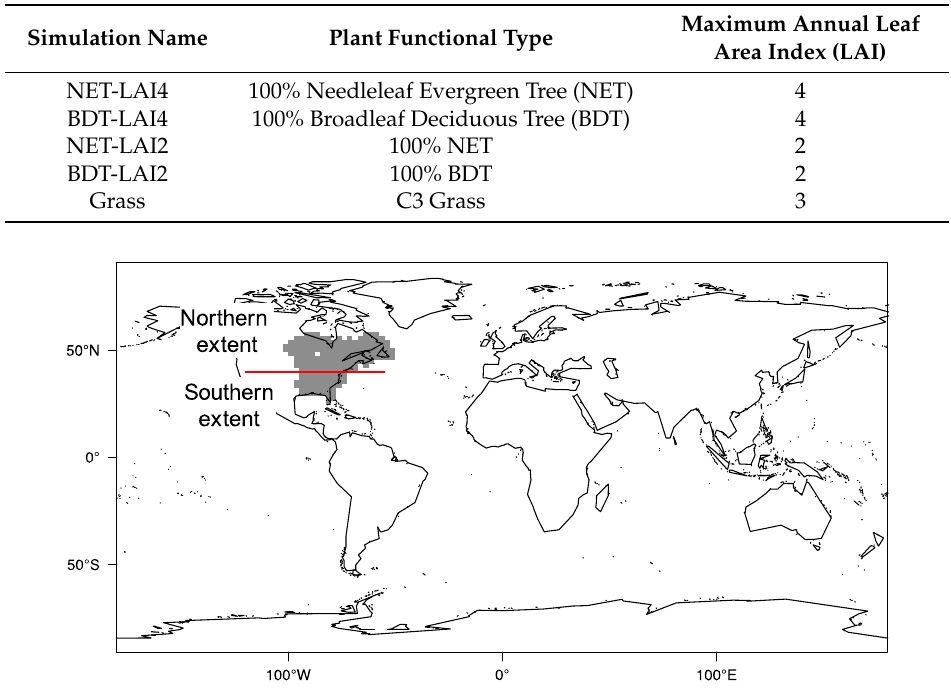
Figure 1. Global simulations were run with where the vegetation in eastern North America (gray region) was modified to represent 100% coverage by each of the plant types in Table 1. We focused our analysis on the modified grid-cells and further divided the analysis into the northern extent (gray area above 40° N) and the southern extent (gray area below 40° N).